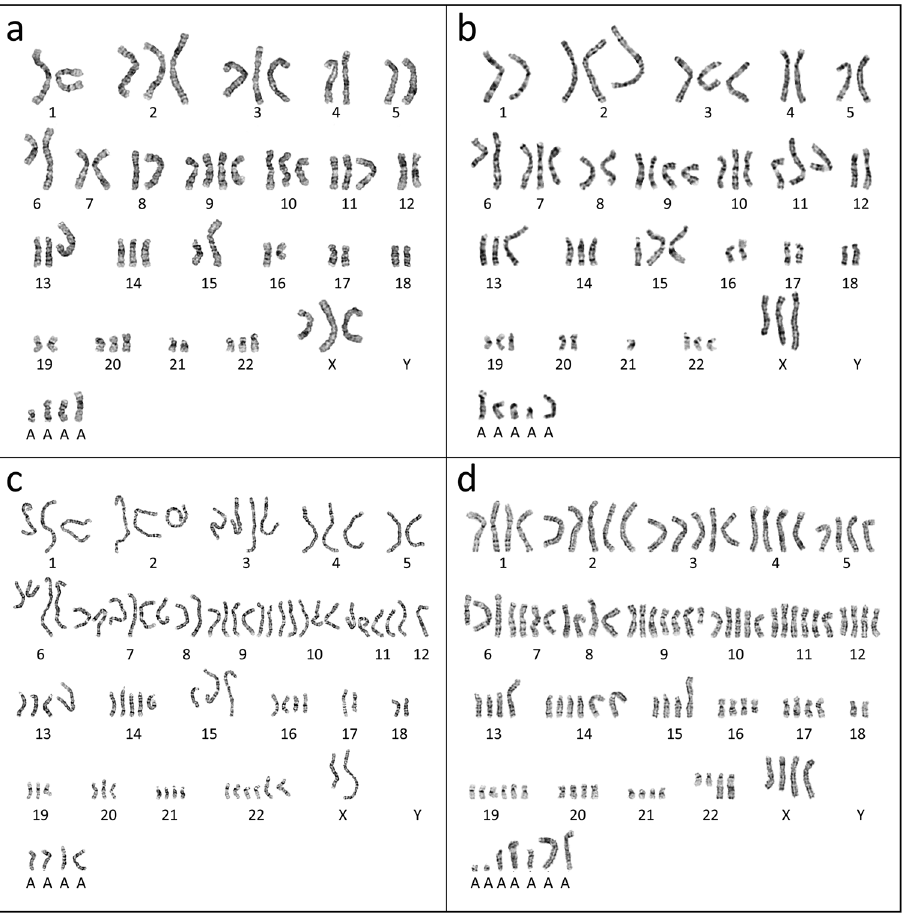
Figure 2. Chromosome analysis of PUMC-CRC1 cells at passage 34. ( a , b ) Representative karyotypes of hyperdiploid cells, accounting for 65% of PUMC-CRC1 cells at P34, with chromosomal numbers ranging from 60 to 68. ( c ) Representative karyotypes of hypertriploid cells, accounting for 15% of PUMC-CRC1 cells at P34, with chromosomal numbers ranging from 89 to 93. ( d ) Representative karyotypes of hypertetraploid cells, accounting for 20% of PUMC-CRC1 cells at P34, with chromosomal numbers ranging from 101 to